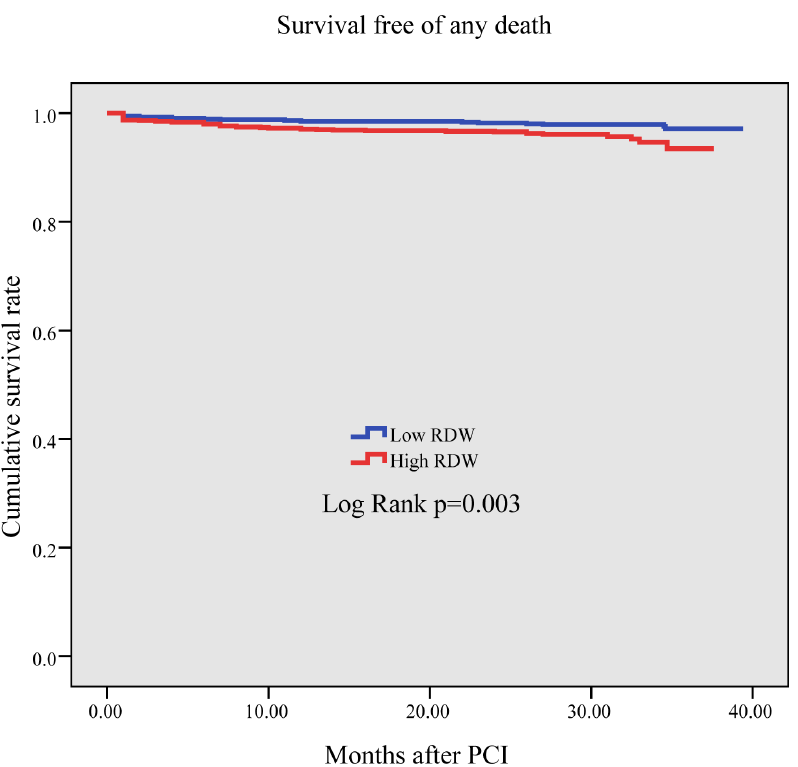
Figure 1. The Kaplan–Meier curve of all-cause mortality rate. It is significantly higher in quartiles 2, 3, and 4 than in quartile 1 (P , 0.001).